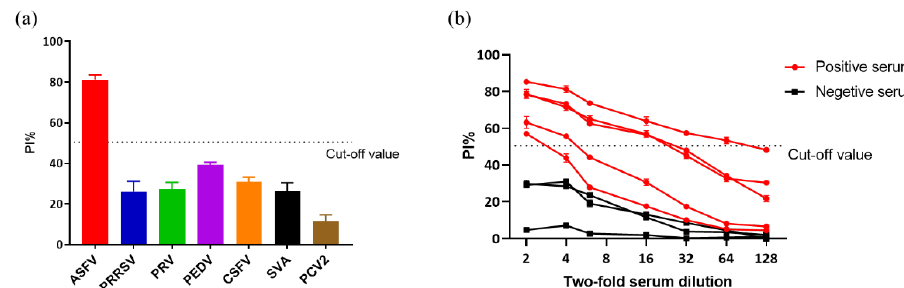
Figure 8. Specificity and analytical sensitivity assay. ( a ). Percent of inhibition of the polyclonal anti − sera against various porcine viruses analyzed by 6A5/6F9 − based blocking ELISA. Only ASFV − positive pig serum showed a higher PI value than the cut − off value. ( b ). Two − fold serially diluted ASFV − positive sera (Red) and ASFV − negative sera (Black) ranging from 1:2 to 1:128 were detected by the blocking ELISA. Cut − off value was marked with a dashed line.